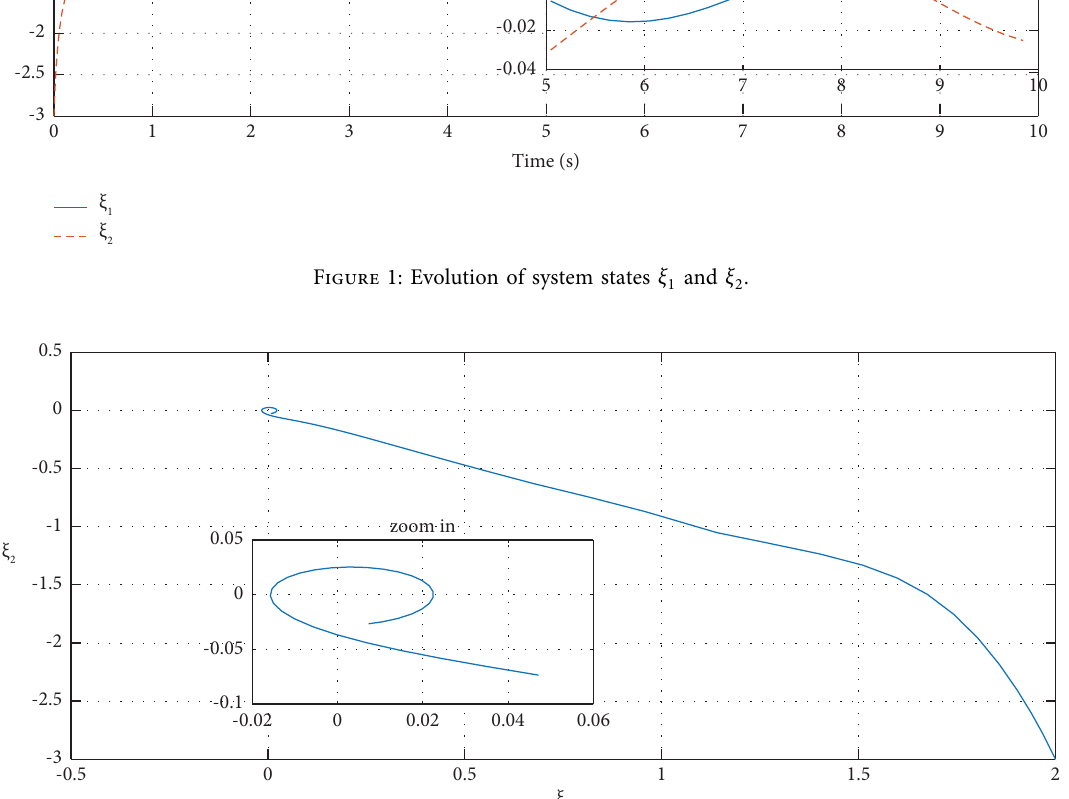
− ξ plane for Example 1. 1 2